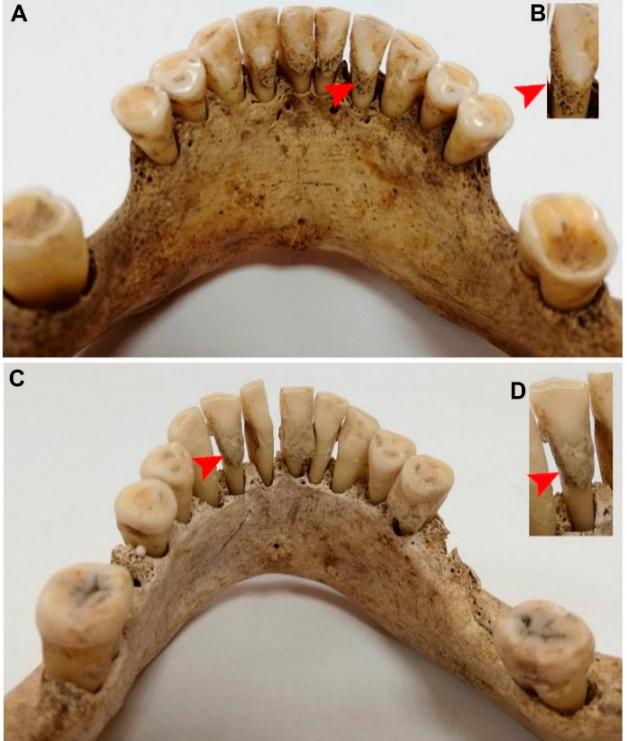
Figure 1. Mandibles with teeth and dental calculus collected from two adults of 17th-century inhabitants of Subcarpathian region: ( A ) mandible, grave 13, male, maturus ; Farny Square, Rzeszow, site 17; ( B ) magnification of right second incisor with dental calculus; ( C ) mandible, grave 3, female, maturus–senilis ; Farny Square, Rzeszow, site 17; ( D ) magnification of left second incisor with dental calculus. Red arrowhead indicates dental calculus.